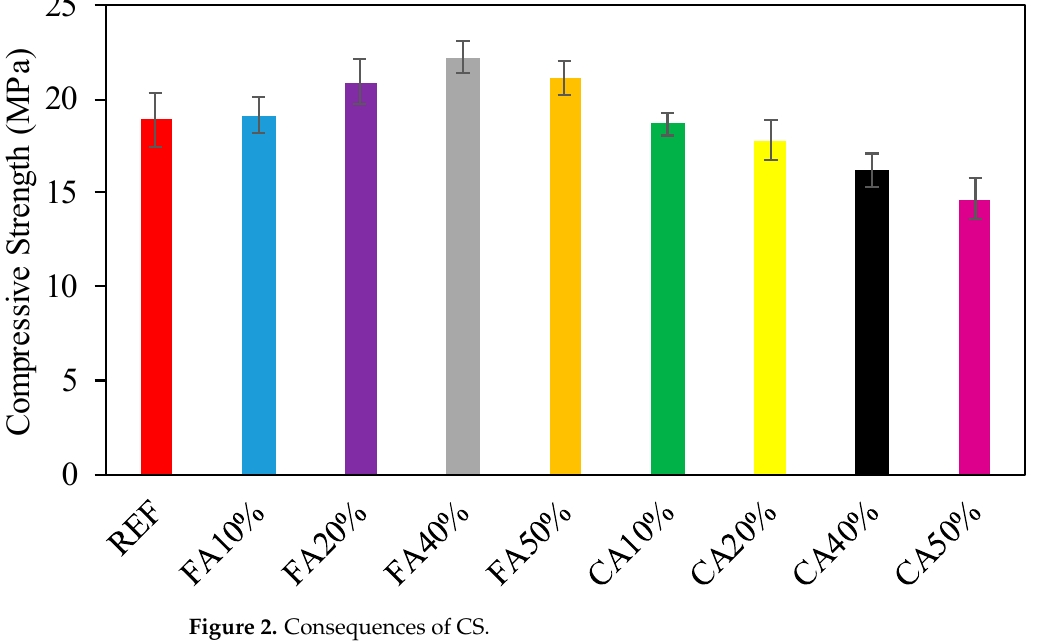
Figure 2. Consequences of CS.